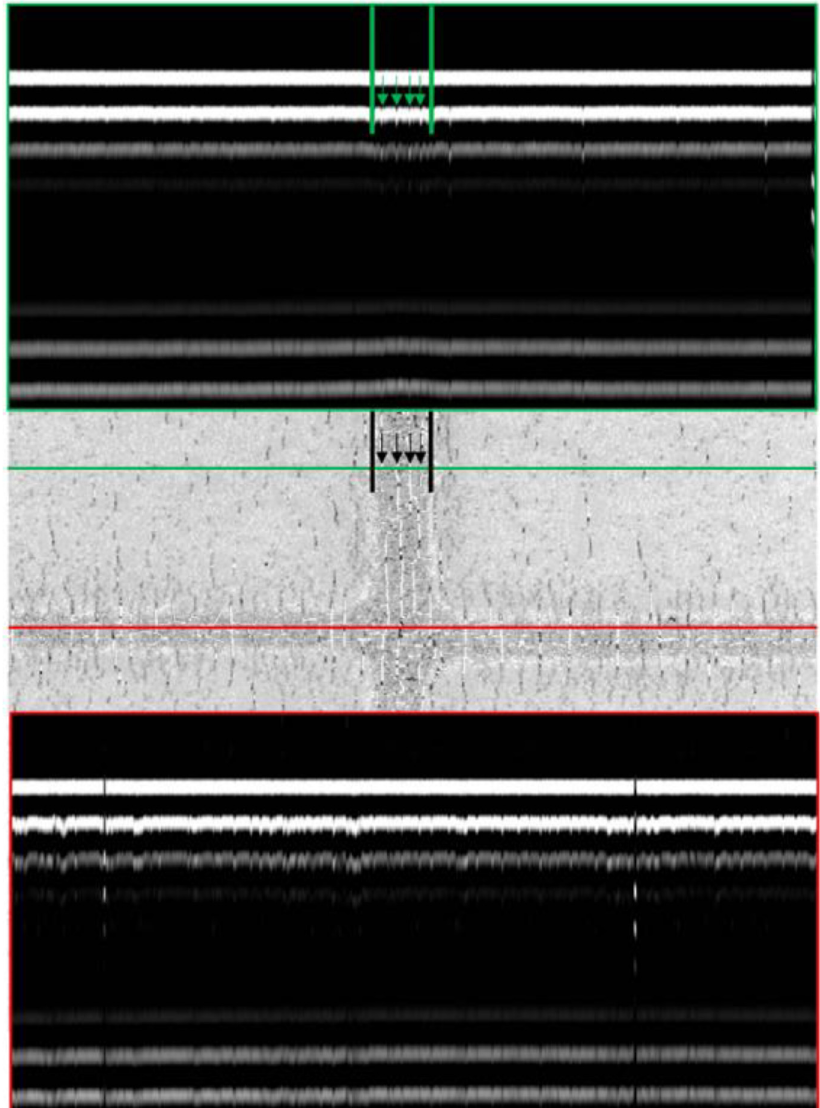
Fig. 8. Acoustic cross-sections of a module with PA/PET/PA backsheet with polyamide outer layer cracking (top and bottom), taken at the lines indicated in the micrograph